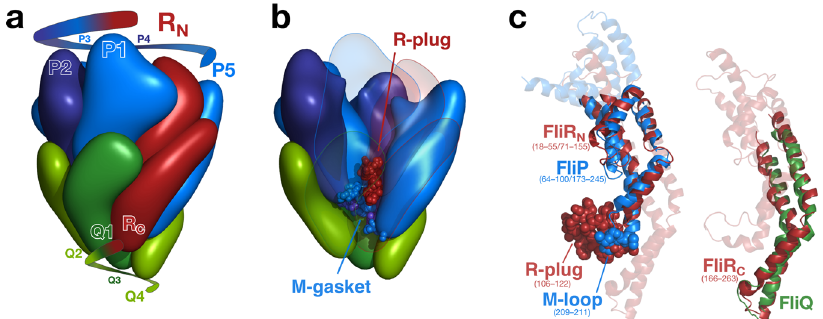
Fig. 1 Organization of the fT3SS pore. a The export gate is composed of FliP/Q/R in a 5:4:1 stoichiometry and is organized in a corkscrew-like helical structure. The R subunit has structural homology that is split between P (R N ) and Q (R C ) (see c ). b The FliR plug (R-plug) and the M-gasket formed of 5 FliP M-loops are located in the core of the pore, sealing it in the closed conformation. c The N-terminal part of FliR exhibits a strong structural homology with FliP, with the exception of a bulky domain (residues 106 – 122) in place of the FliP M-gasket. The C-terminus of FliR is similar to FliQ on its full length. The structures in ( a ) and ( b ) are based on the 6f2d PDB entry. The isosurface at downscaled resolution (8 Å ) was computed to better illustrate the global shape and organization of the